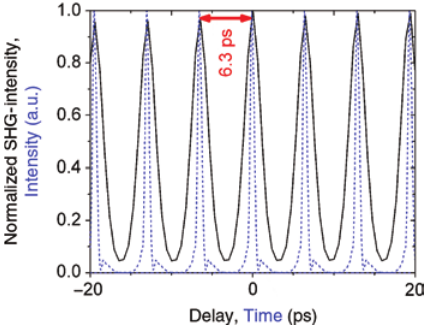
Figure 10: Repetition rate of a chirp compensated QD MLL pulse comb at 160 GHz using an optical time division multiplexer, SHG autocorrela- tion measurement (black), and corresponding pulse comb